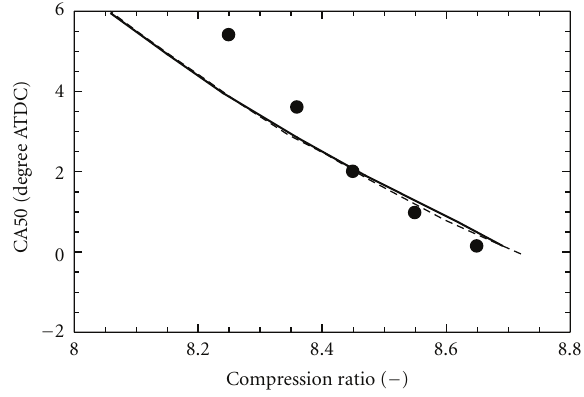
Figure 9: Comparison of CA50 versus compression ratio (CR): Symbols: data taken from CFR with ( φ = 0 . 33) and ambient temperature and pressure; Solid lines: single zone model using detailed DME chemistry [10] with T 0 = 305K; dashed lines: single zone model 28-species reduced DME chemistry with T 0 = 314K (this